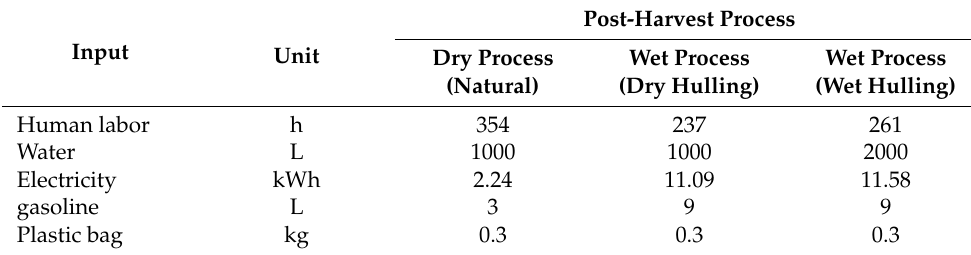
Table A3. Inventory data for 1 ton of cherry bean processing in the post-harvest process stage.